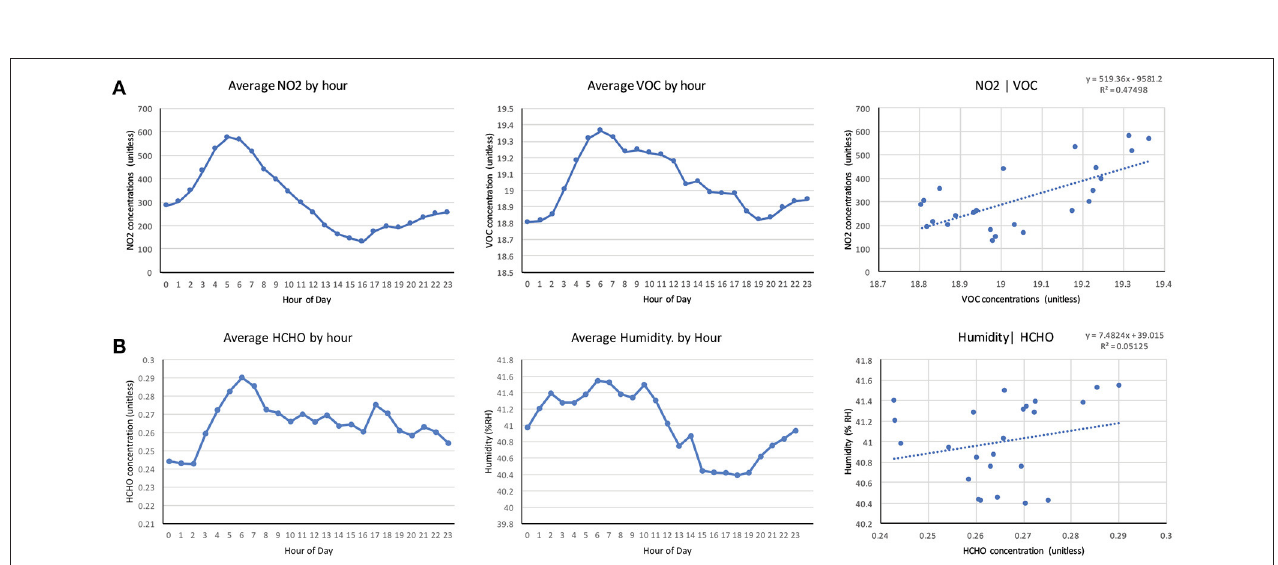
FIGURE 7 | Average hourly values from the NO 2 and VOC sensors at the PhD West location (A) , demonstrating an R 2 of 0.47, indicating the likelihood of a common influence. Average hourly values from the HCHO and relative humidity sensors (B) , R 2 of 0.05, indicates an unlikely common influence.